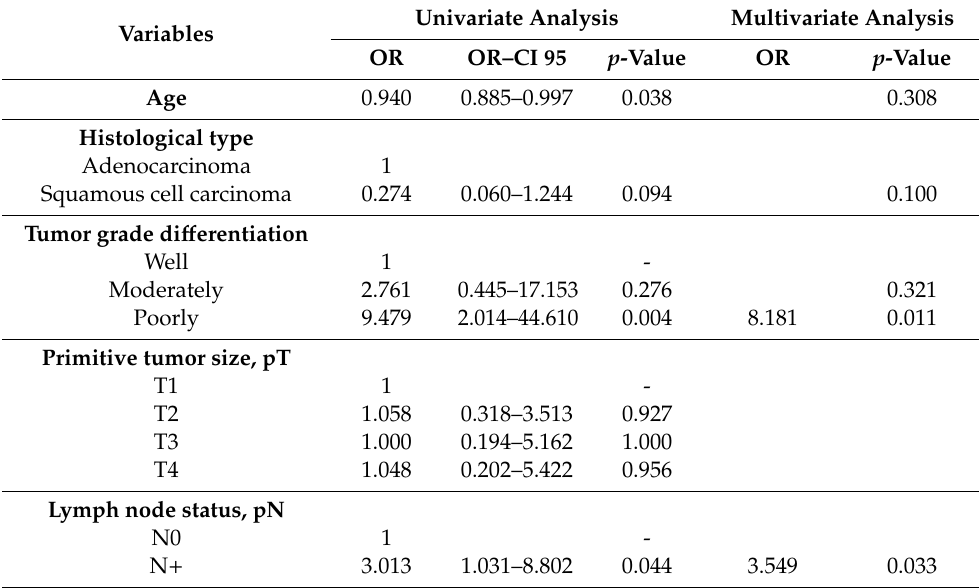
Table 1. Factors associated with PD–L1 and vimentin co-expression in